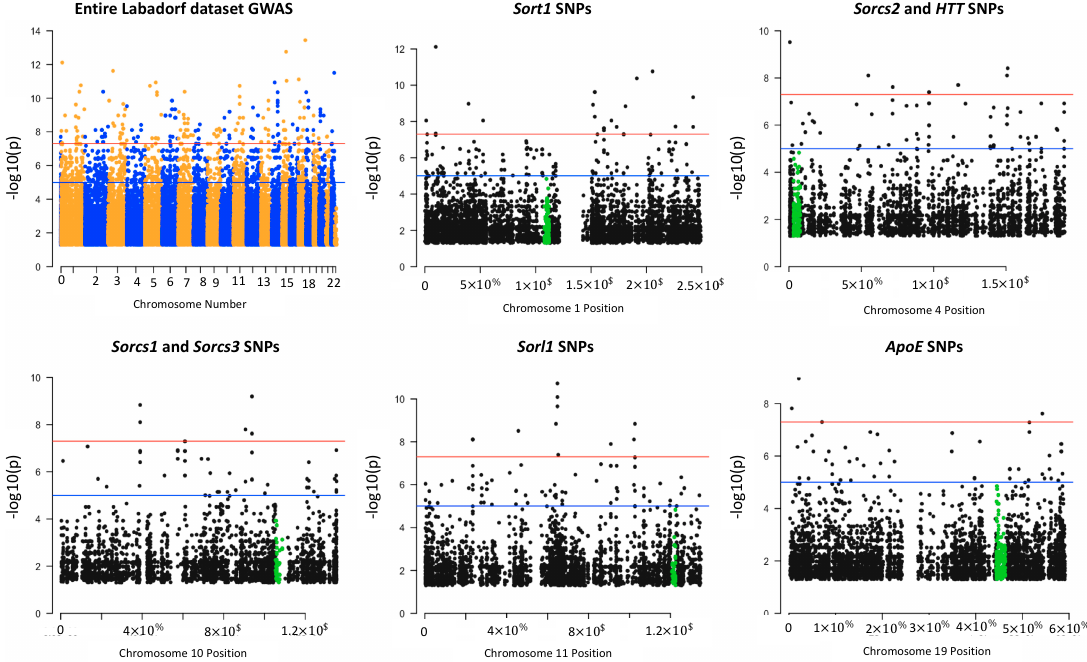
Figure 3. Manhattan plot visualization of SNPs found significant ( p -value < 0.05) in regions near HTT , sortilins and APOE in the Labadorf 2015 dataset. Some of the genes were located in the same chromosome ( HTT and SORCS2 on chromosome 4, SORCS1 and SORCS3 on chromosome 10). When the chromosome was identical, significant SNPs were counted as SNPs located 1,000,000 bp upstream and downstream the gene border coordinates. The level of significance (negative log of p -value, y axis) of SNPs identified near the sortilin genes suggested that the genetic variation in sortilins have a significant impact on the Huntington’s disease (HD) pathology in this dataset.